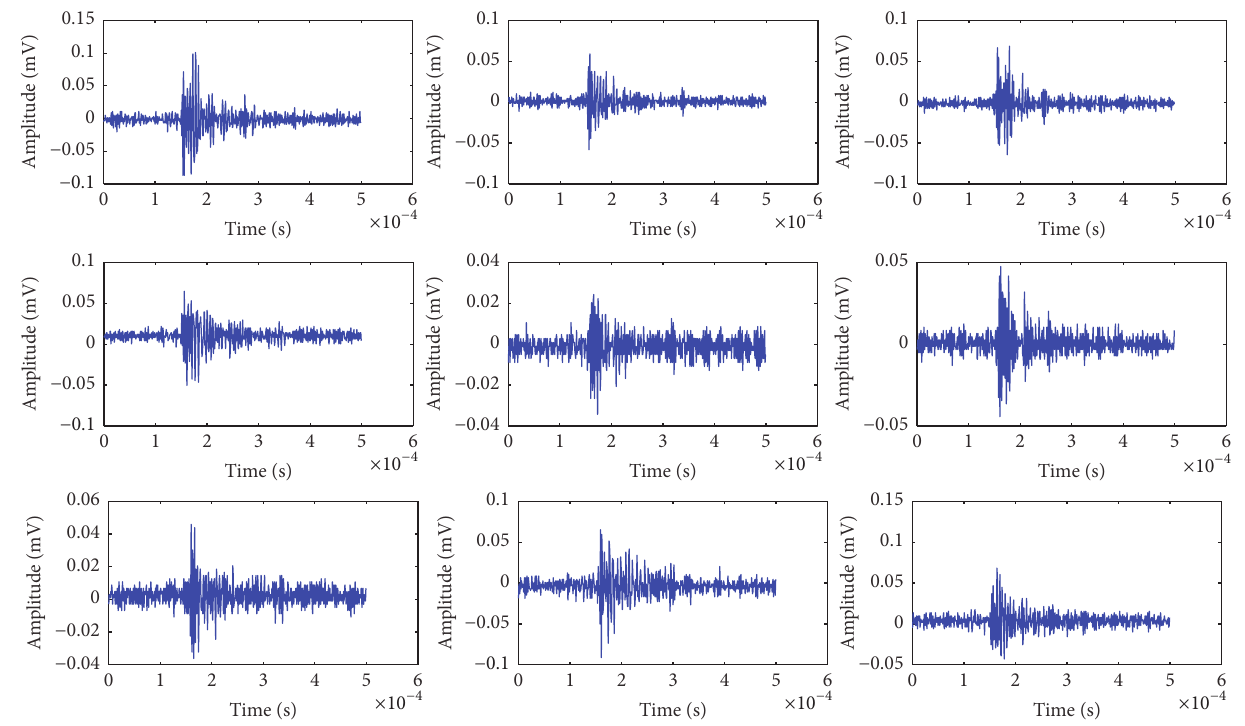
Figure 13: Nine channel ultrasonic signal